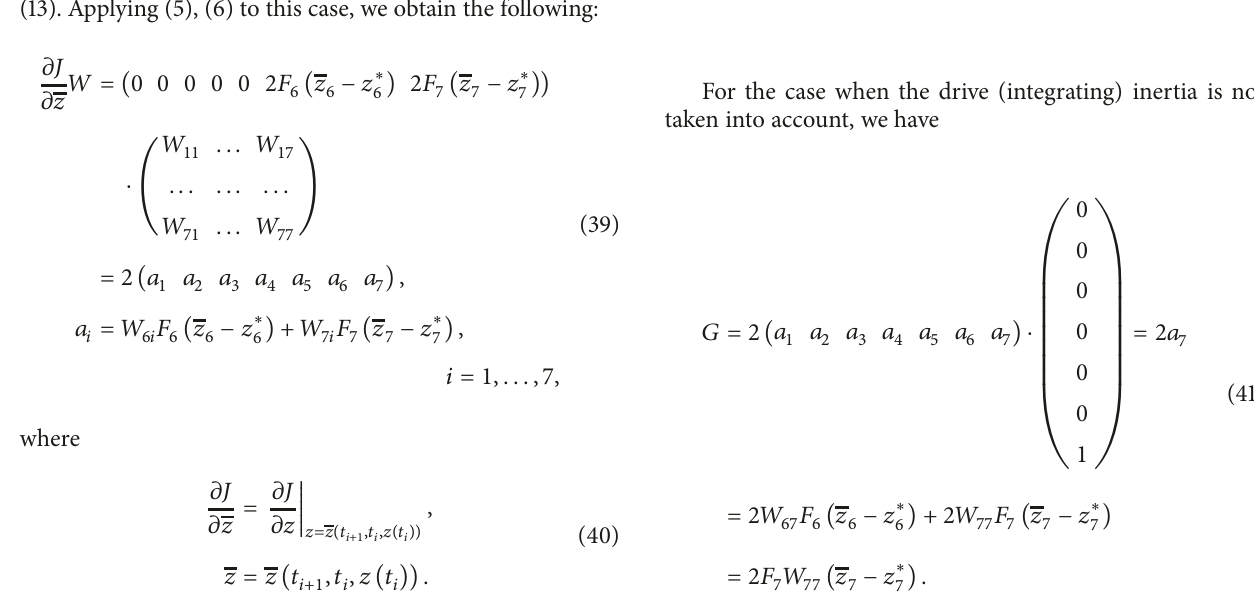
Figure5:Timedependenceoftherobotrightwheelangularvelocity (control